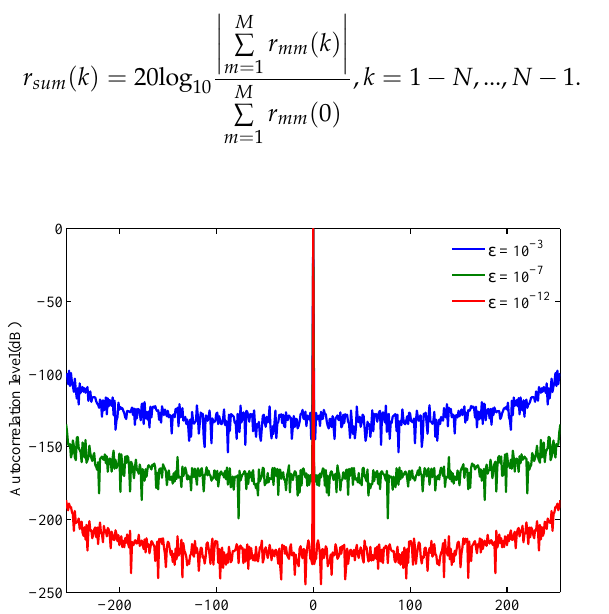
Figure 3. The autocorrelation sum of the waveform sets designed by the Gra-Corr-SFW with different ε . ( N = 256, M = 3)